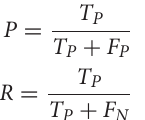
made the regression of the target box more stable. The schematic diagram is shown in Figure 5